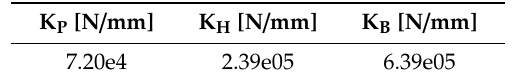
Table 5. Actuators, contact, boring bar and equivalent sti ff ness.